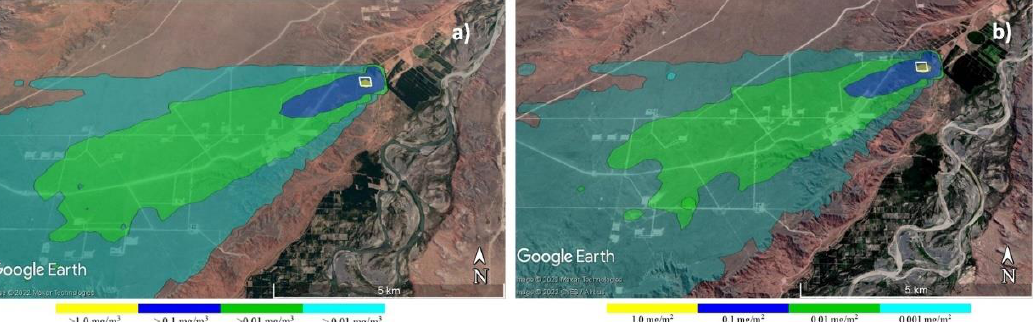
Figure 3. ( a ) Bioaerosol concentration downwind from the feedlot from HYSPLIT on 20 February 2020 at 13:00 UTC considering an emission source located from 0 to 1.5 m above the ground ( b ) deposition from HYSPLIT 20 February 2020 at 14:00 UTC.